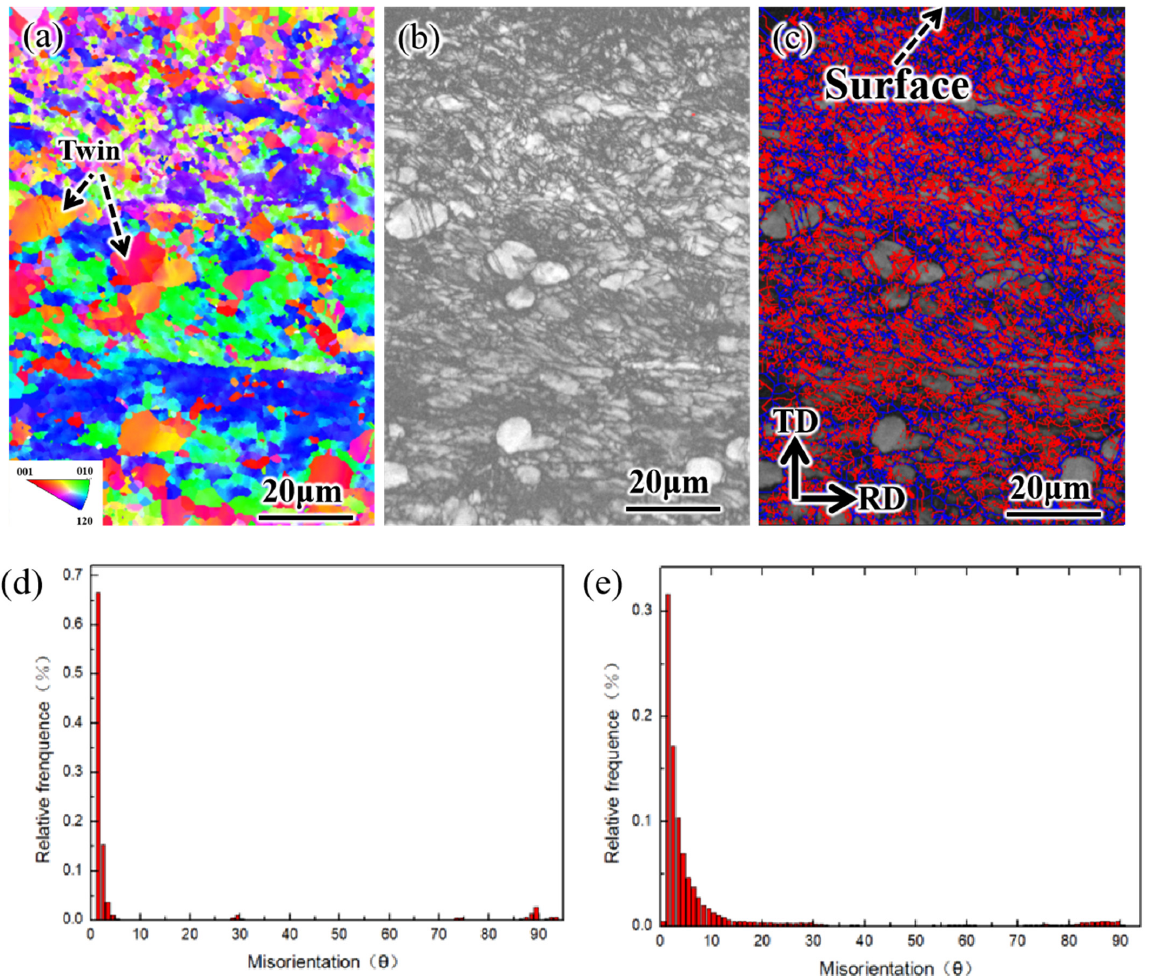
Figure 9. EBSD characterization of microstructure after surface ultrasonic rolling. ( a ) IPF map, ( b ) BC map, ( c ) boundary orientation map (red line > 10°, blue line 2–10°), ( d ) matrix boundary angle distribution, ( e ) surface boundary angle distribution.